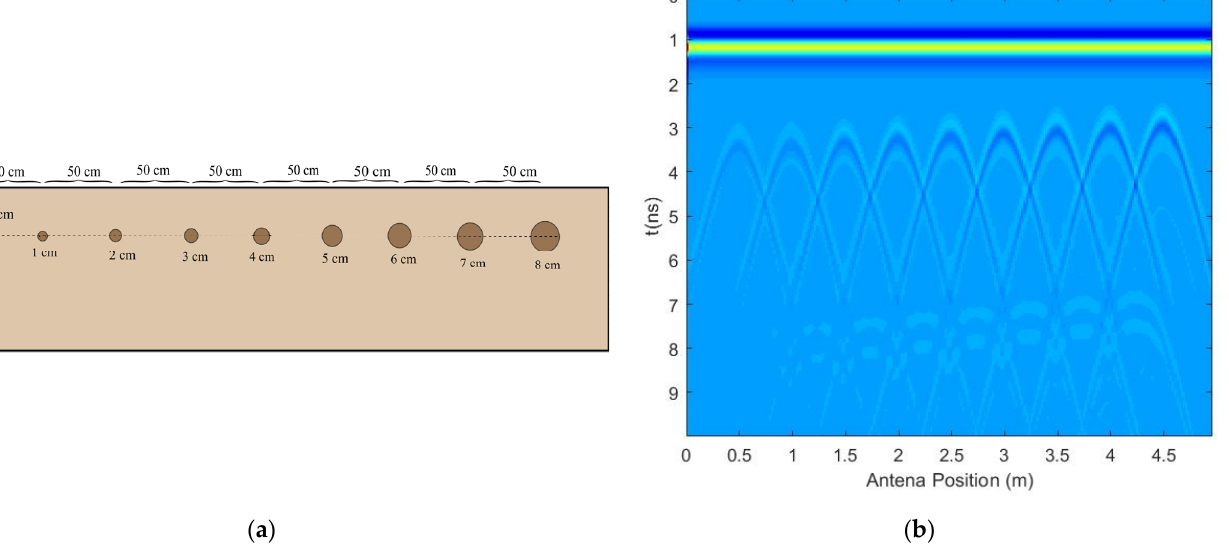
Figure 13. Simulation of different root diameters: ( a ) simulation model; ( b ) simulation image.